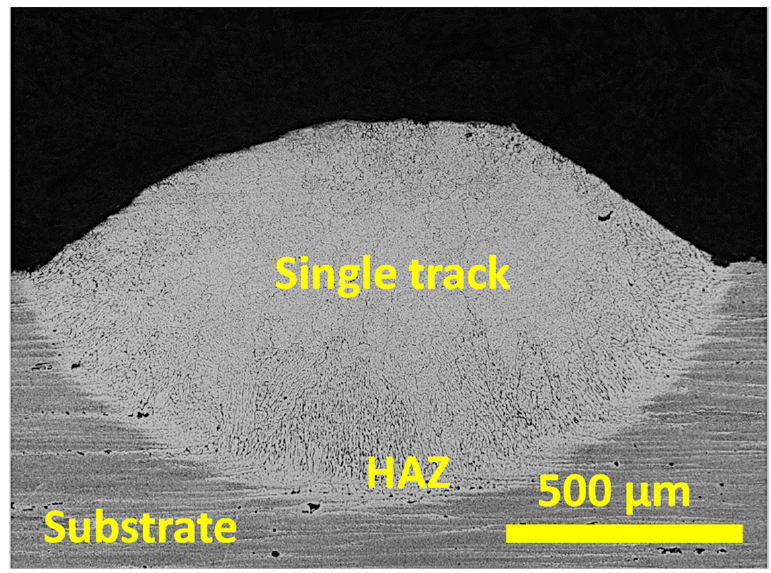
Figure 13. Representative optical micrograph cross-section of the samples manufactured with a powder feed rate of 1.4 g/min.